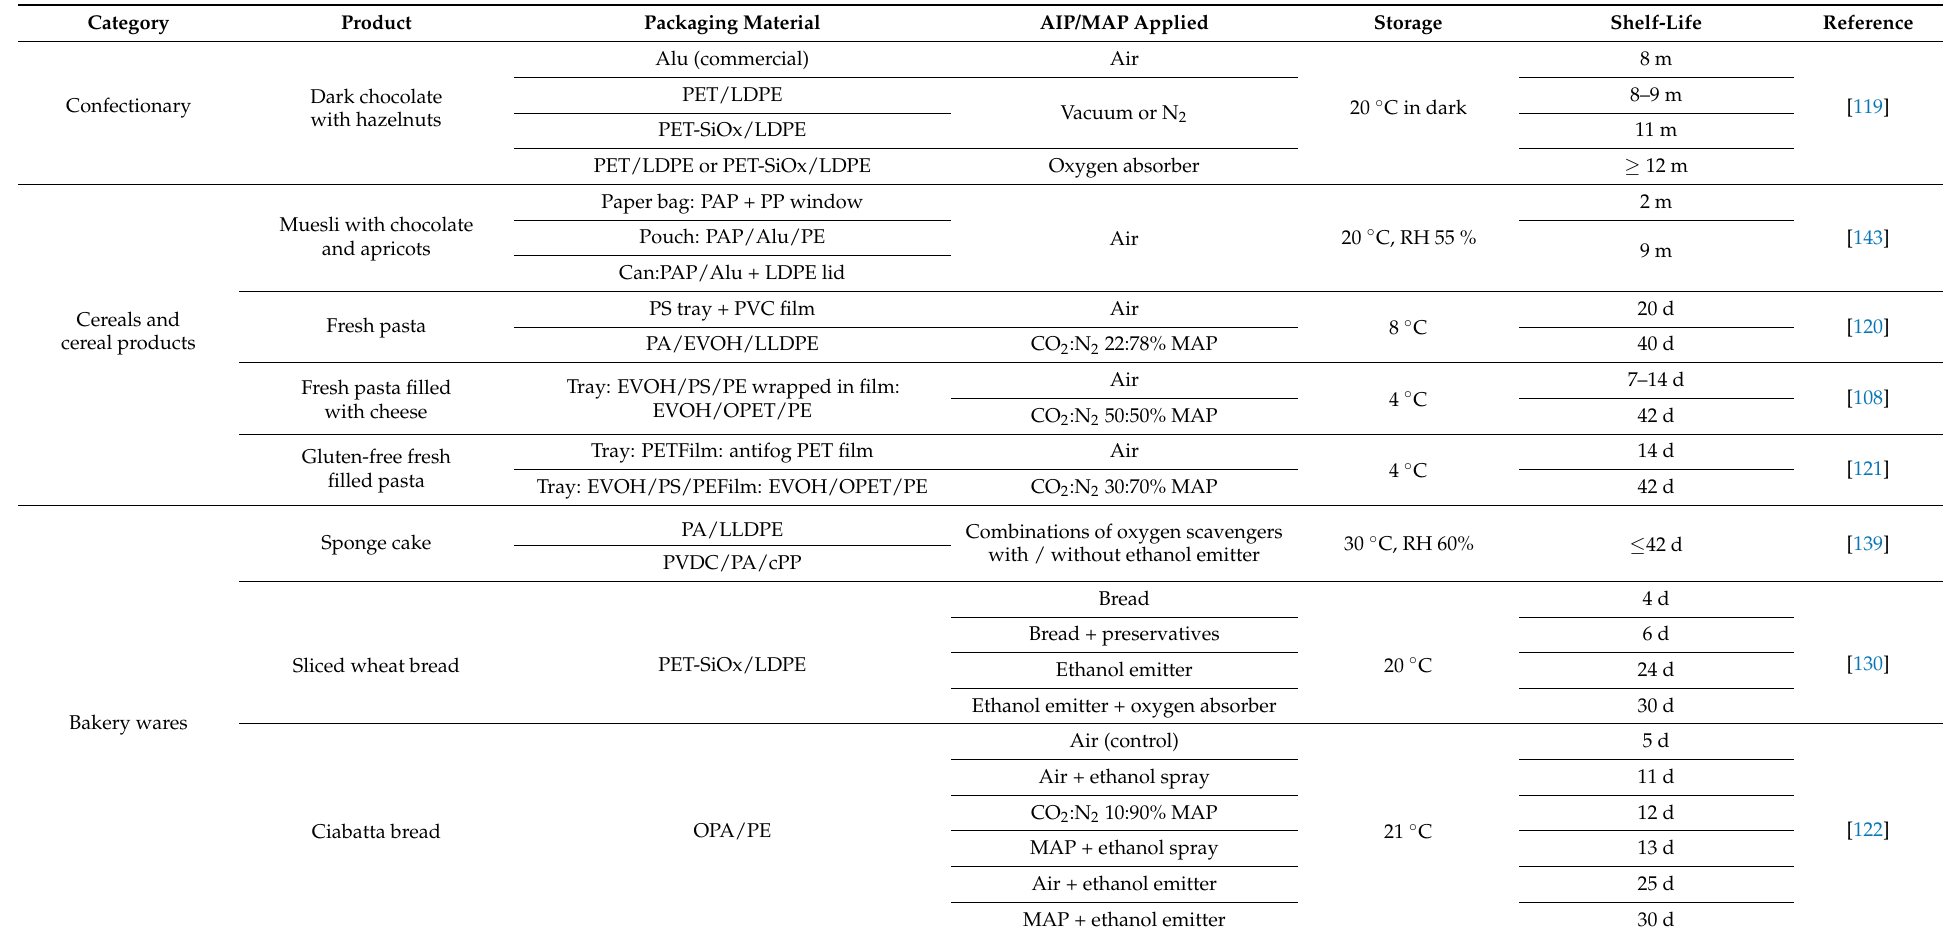
Table 3. Effects of packaging material selection, active packaging (AP) and modified atmosphere packaging (MAP) on shelf-life extension of cereal and